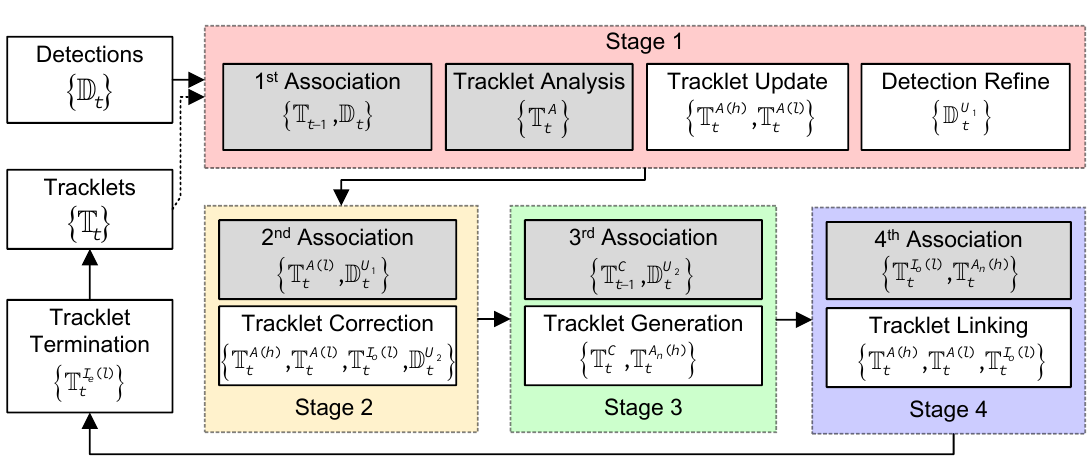
Figure 1. The framework of the proposed algorithm. The symbols in the gray bounding box are the input to the processing stage, and the symbols in the white bounding box are the